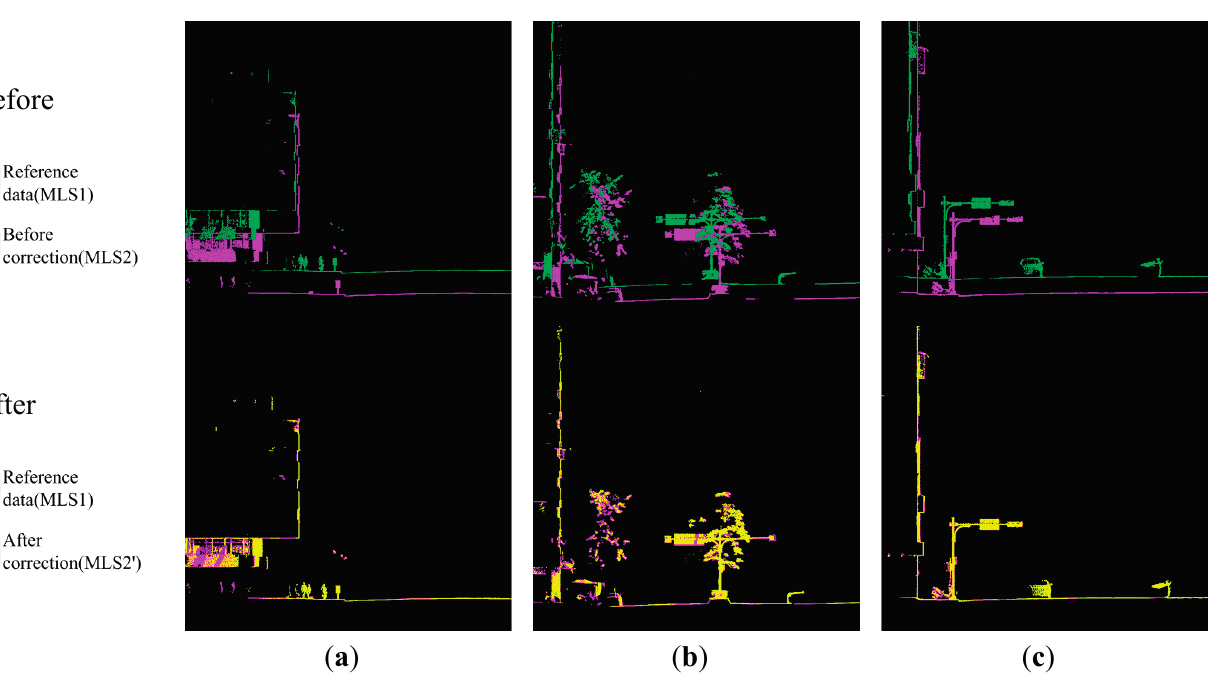
Figure 10. Profiles of MLS before and after registration: ( a ) profile A, ( b ) profile B, ( c ) profile